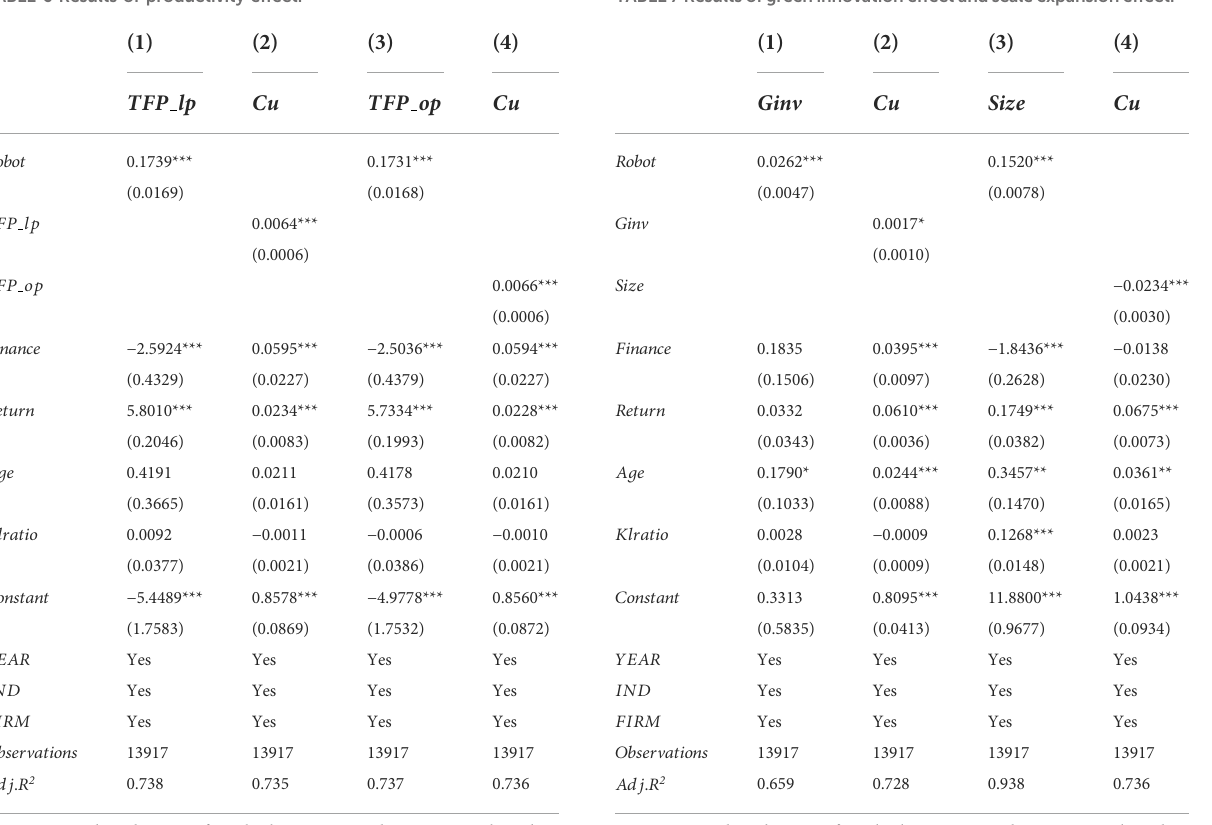
TABLE 6 Results of productivity effect.